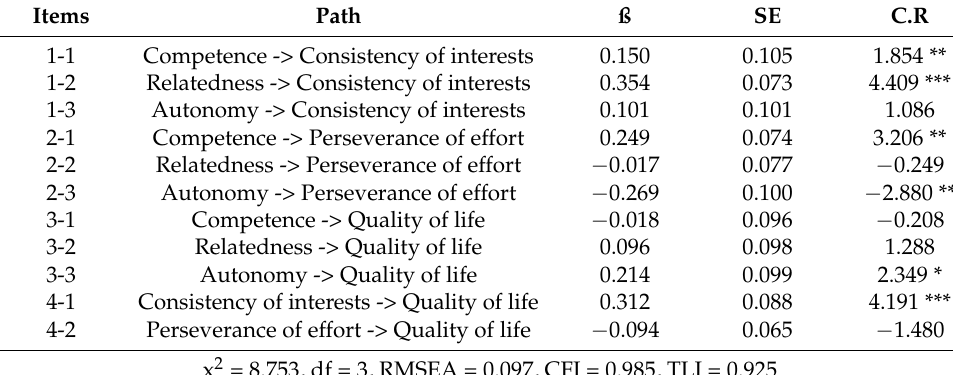
Table 3. Result for structural equation